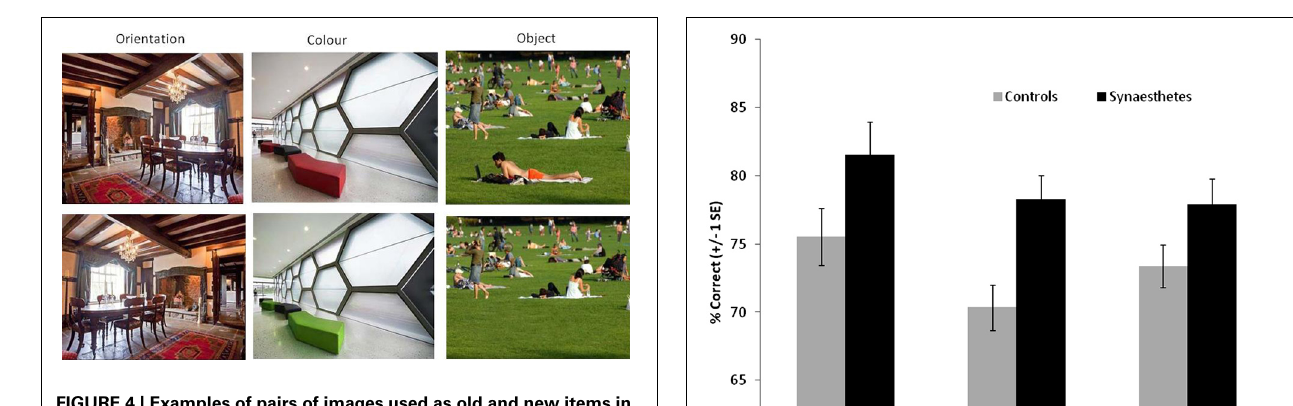
FIGURE 4 | Examples of pairs of images used as old and new items in Experiment 2.